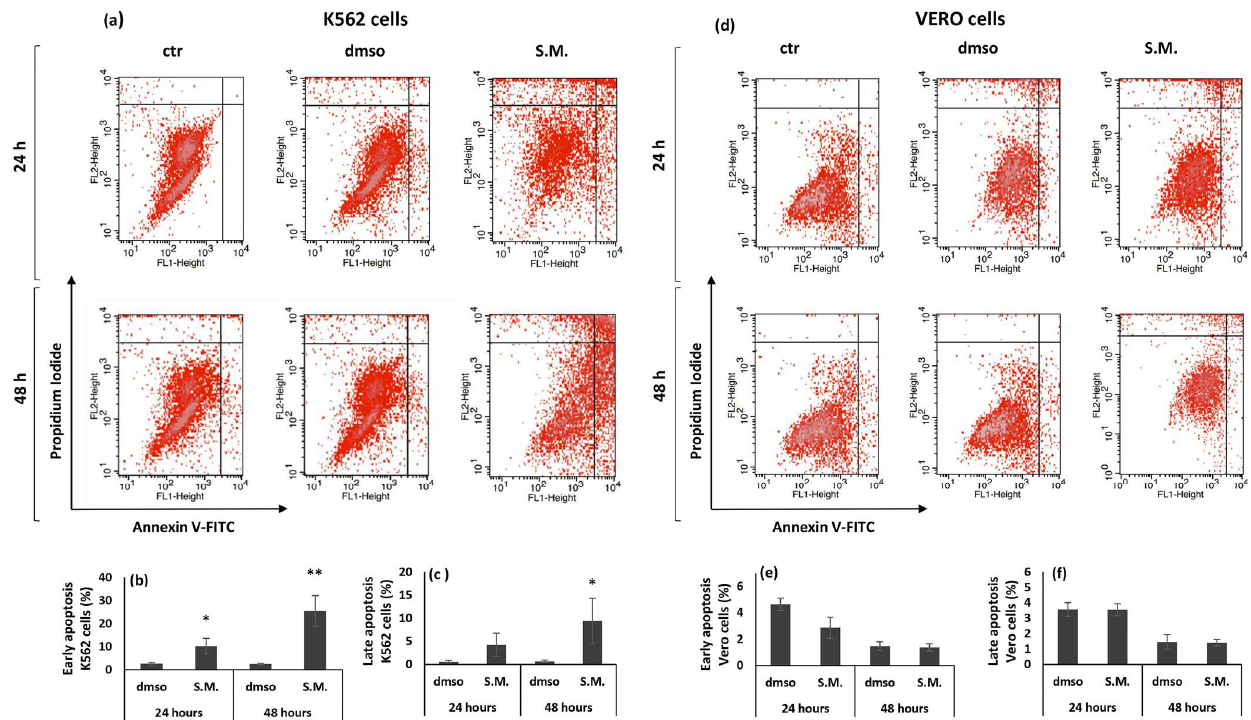
Figure 2. Cytofluorimetric measurement of apoptosis induced by Skeletonema marinoi (S.M.) (0.75 mg/mL) on K562 and Vero cells. Panel ( a , d ): scatter plots of the annexin V-FITC/PI flow cytometry graphs by FACS. The lower right quadrants represent cells in the early stage of apoptosis. The upper right quadrants represent cells in the late stage of apoptosis. Representative quantification of early ( b , e ) and late ( c , f ) apoptosis in dmso- and S.M.-treated K562 and Vero cells. Data are expressed as the mean ± standard deviation (SD) of three experiments. Statistical differences between control and S.M. were evaluated by Student’s t -test (* p < 0.05 versus dmso; ** p < 0.01 versus dmso).